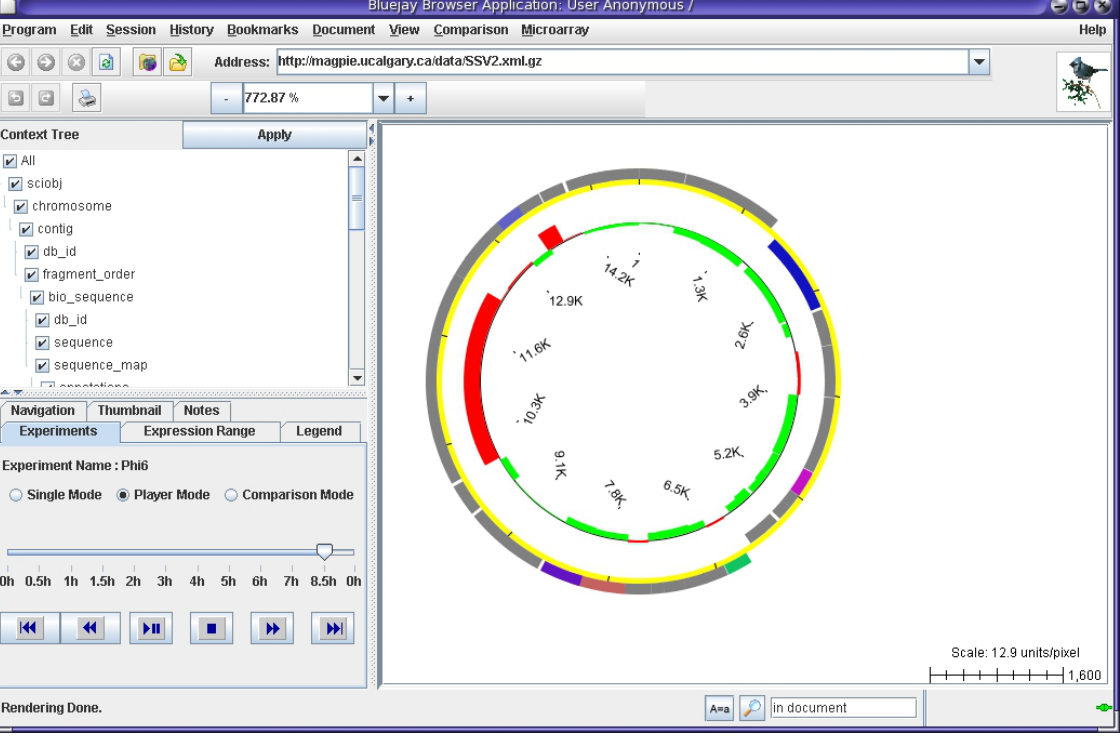
Figure 1: Bluejay in microarray Player viewing mode, with a dataset for Sulfolobus spindle- shaped virus 2 (SSV2) at 8.5 hours after infection loaded. Up-regulated genes are shown by red outer bars on the microarray lane, down-regulated genes by green inner